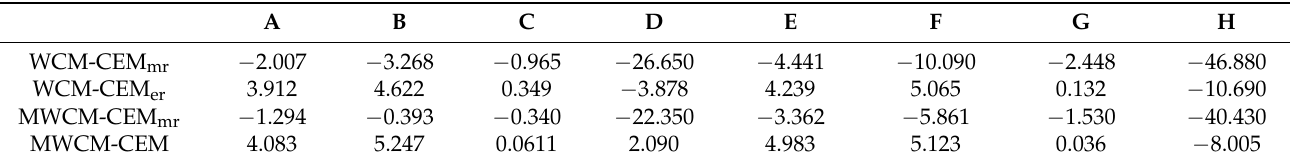
Table 2. Coefficients fitted by least square method for four